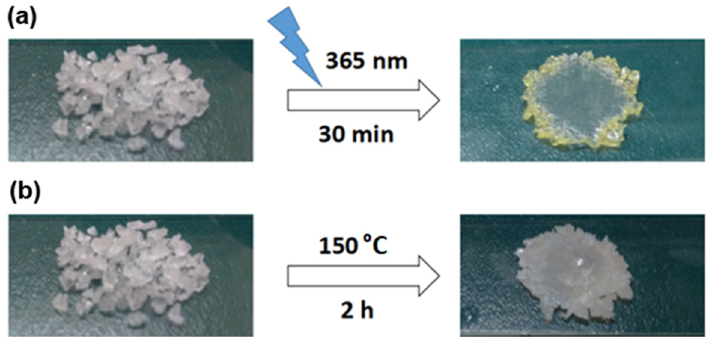
Figure 6. Self-repairing experiments of SE-3 under UV light (365 nm) for 30 min ( a ) or heating at 150 °C for 2 h ( b ).